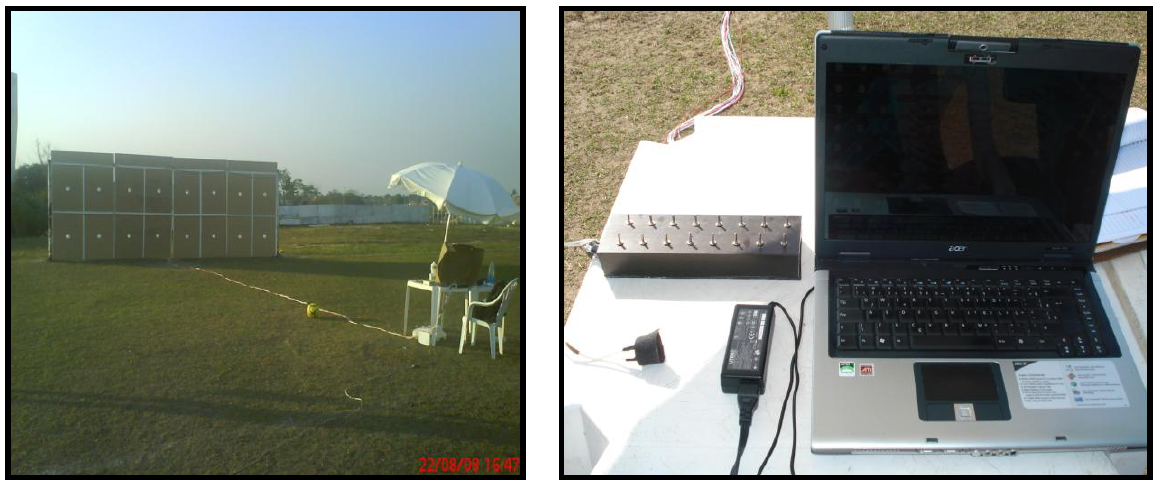
Figura 1: Equipamentos utilizados como o gol e diversos estímulos luminosos, eletromiógrafo de superfície e o posicionamento do